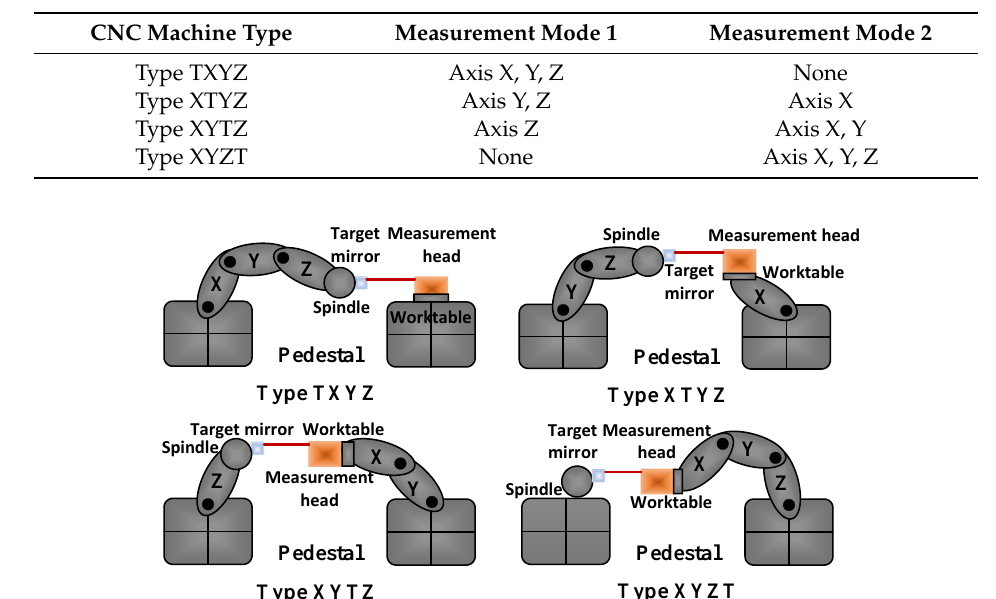
ff erent types of machine tools with unified Figure 1. Measurement process of the different types of machine tools with unified installation. Figure 1. Measurement process of the di